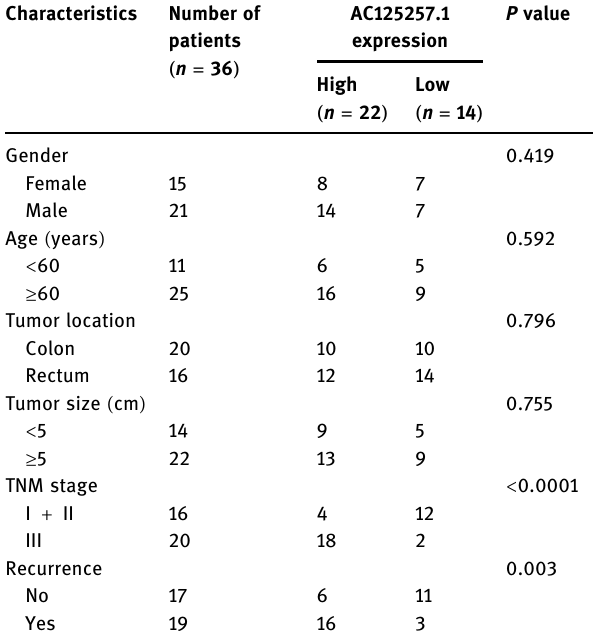
Table 1: Correlation between AC125257.1 expression and clinico - pathologic characteristics of CRC patients